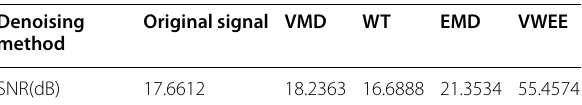
Table 1 Comparison of noise reduction performances of various methods